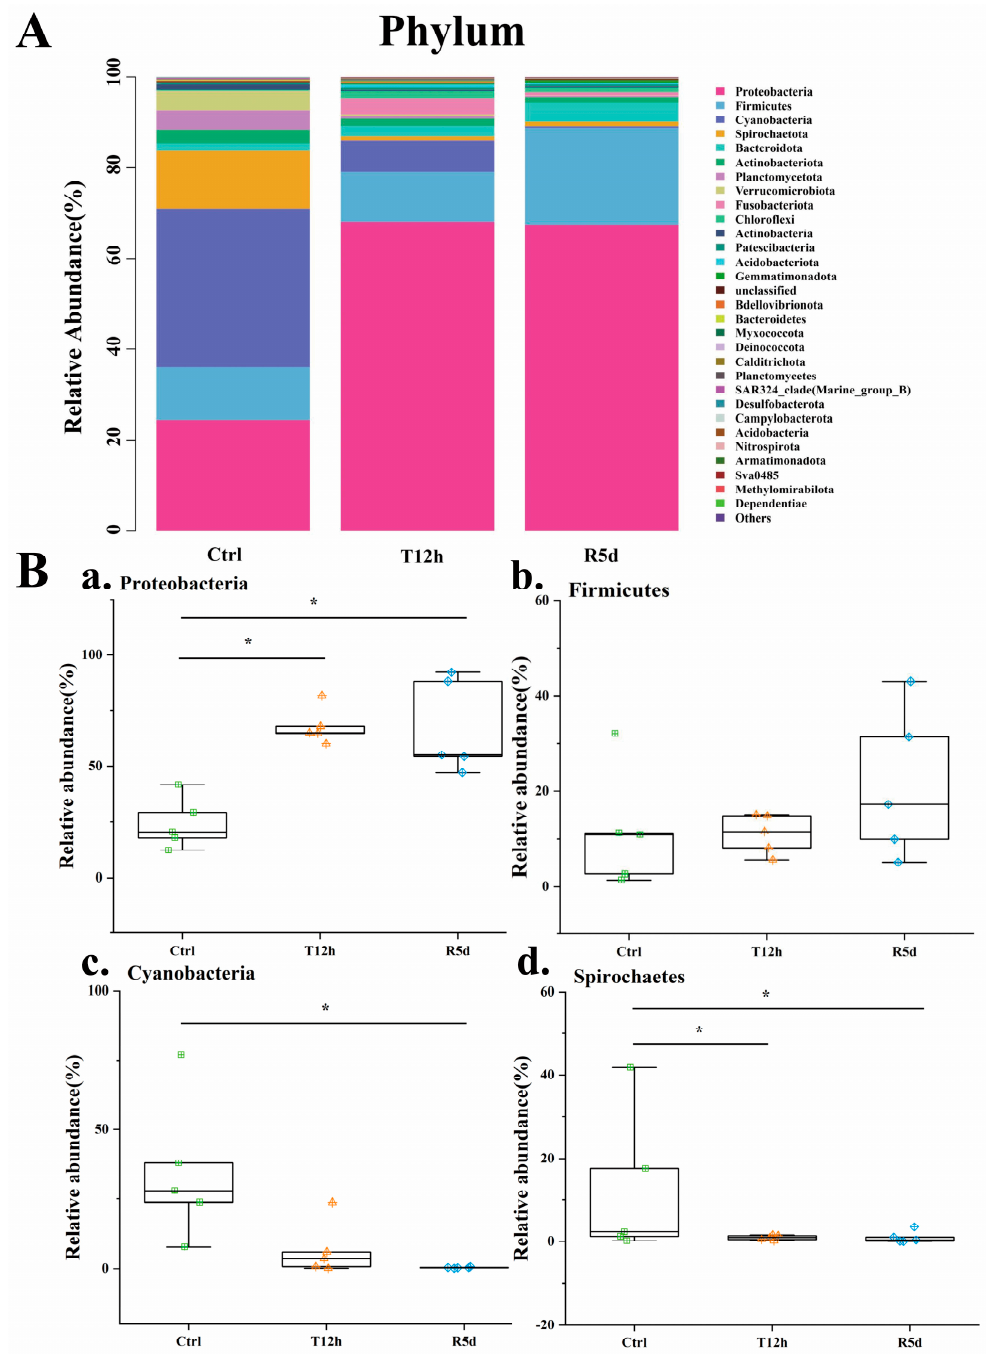
Figure 5. ( A ) Relative abundances of dominant phylum-level taxa in the control (Ctrl), 12 h transport (T12h) and recovery (R5d) groups. Species with lower abundances were classified as “others”. ( B ) Relative abundances of the dominant phylum-level bacteria ( a – d ) in the Ctrl, T12h and R5d groups. * significant difference between the control and treatment groups (Kruskal-Wallis H test, *: p < 0.05).